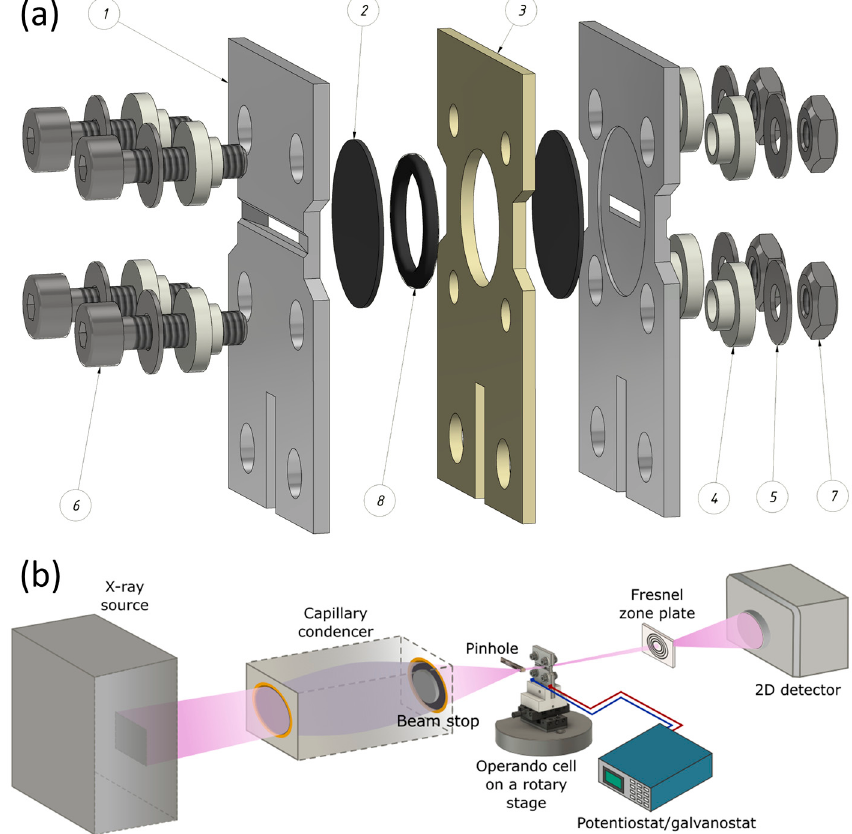
Figure 1. ( a ) Schematic representation of the electrochemical operando cell, including: (1) stainless steel enclosure plate, (2) glassy carbon window/current collector, (3) polyamide spacer, (4) polyamide insulator, (5) washer, (6) bolt, (7) nut, (8) sealing O-ring; ( b ) schematic representation of the